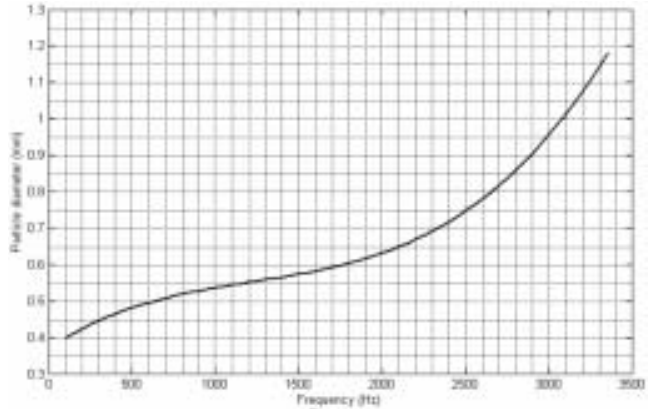
Fig. 27. The relationship between particle diameter and frequency.